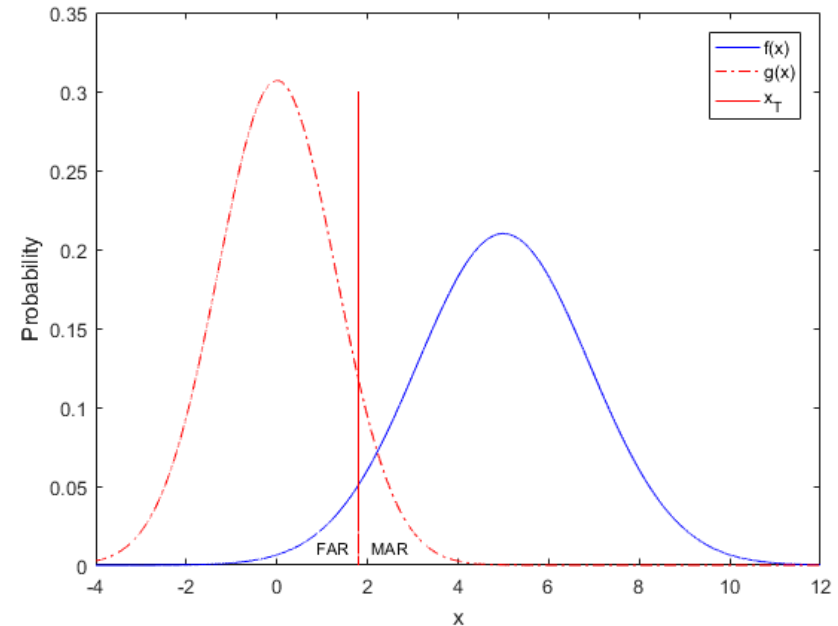
Figure 1. Process probability density curves of x .